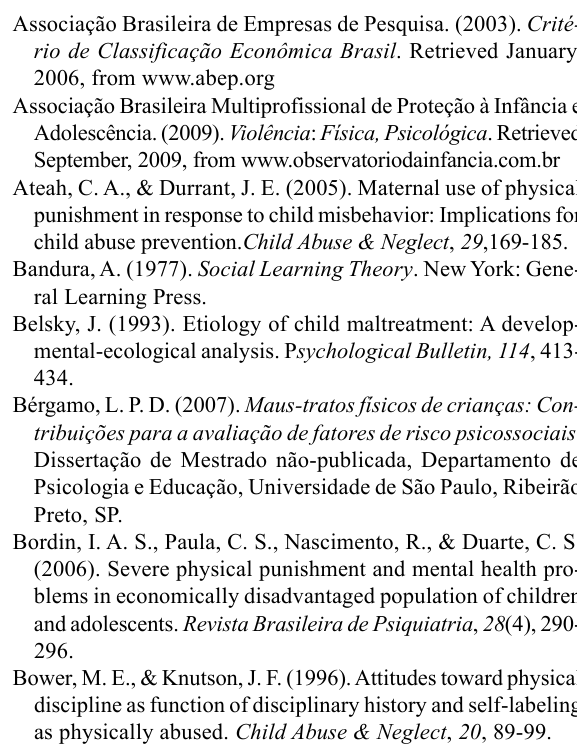
Associação Brasileira de Empresas de Pesquisa. (2003).